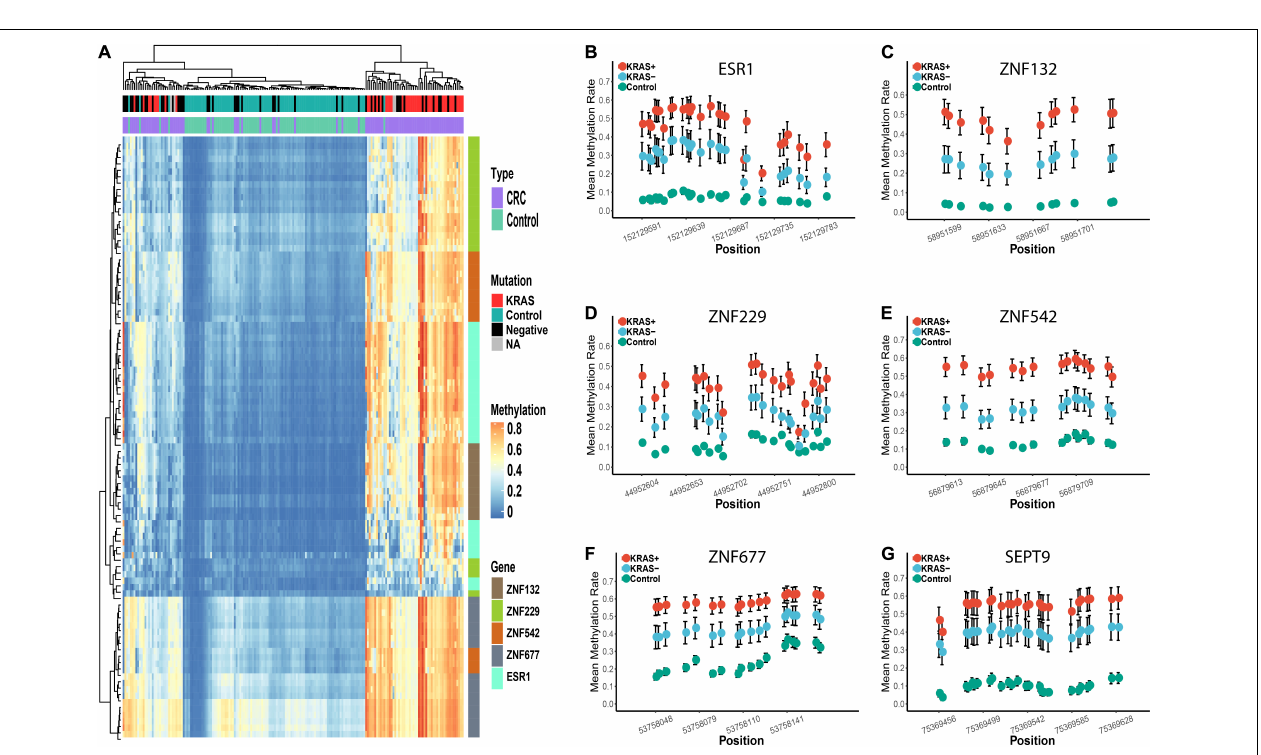
FIGURE 4 | Differential methylation profiles of these candidate biomarkers in KRAS + and KRAS- subgroup in replication cohort 1. Panel (A) represents the heatmap of the methylation levels of these five candidate genes. The tumor and para-tumors tissues were differently colored. The KRAS mutation status of the CRC tumors is also differently colored. Panels (B–G) represents the methylation profiles of the five zinc finger genes and SEPT9. The mean methylation percentage of each CpG site is shown for KRAS +, KRAS- and control groups.